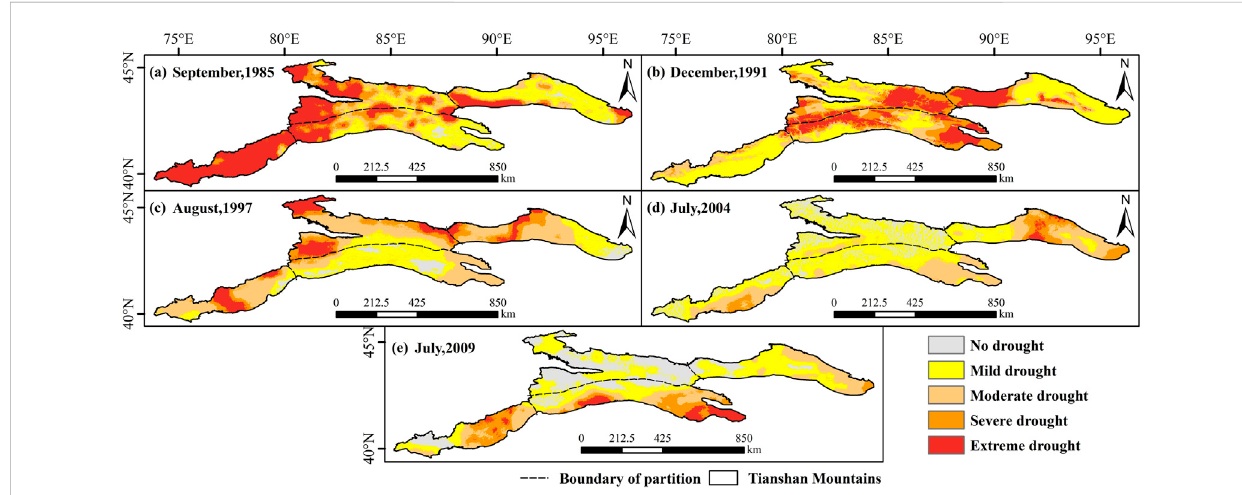
FIGURE 12 Spatialdistributionofdroughtpeakin fi vetypicaldroughtevents (A) September,1985; (B) December,1991; (C) August,1997; (D) July,2004; (E) July,